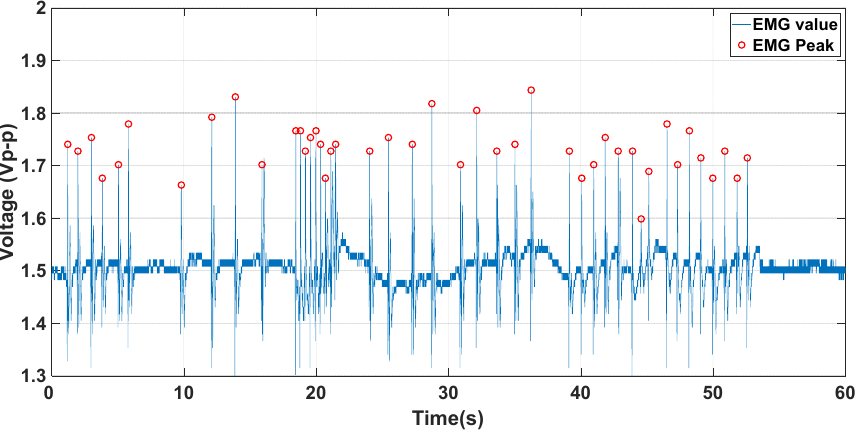
Figure 10. Peak detection of the ASM S & C algorithm.